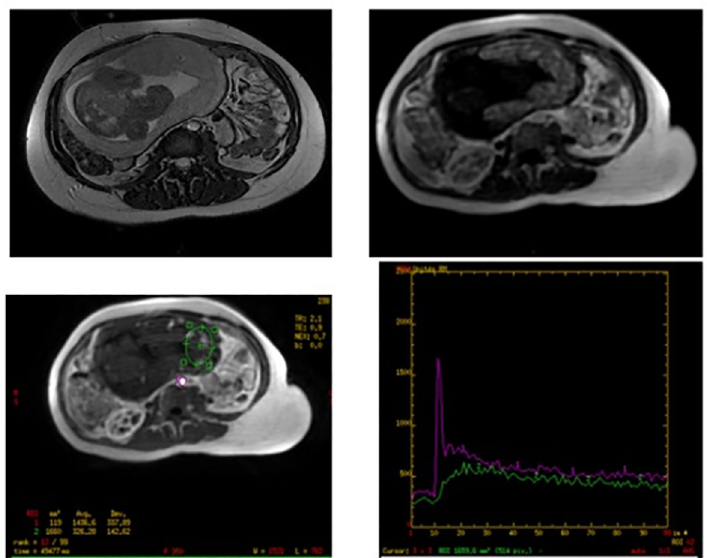
Fig 4. Example DCE time activity curve with model fit from a relevant placental region of interest.